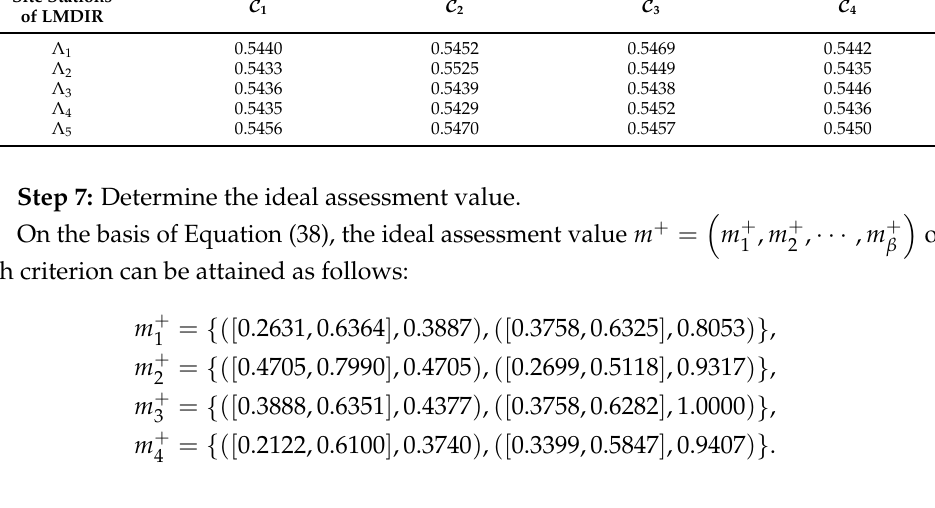
Site Stations of LMDIR